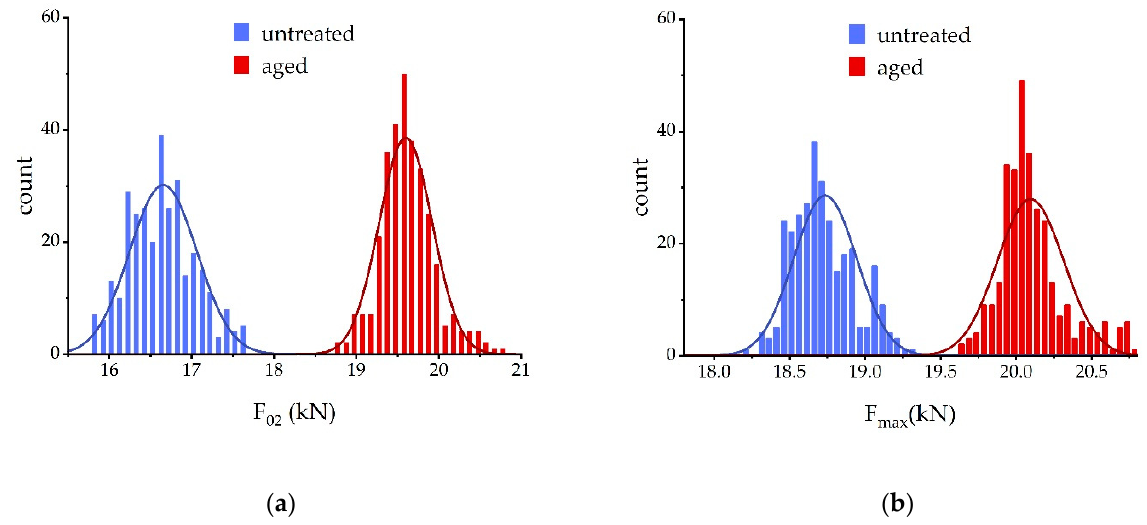
Figure 6. Histograms of ( a ) force at yield and ( b ) maximum force for Ø3.6C compact steel cord in untreated and 150 °C/45 min aged conditions.